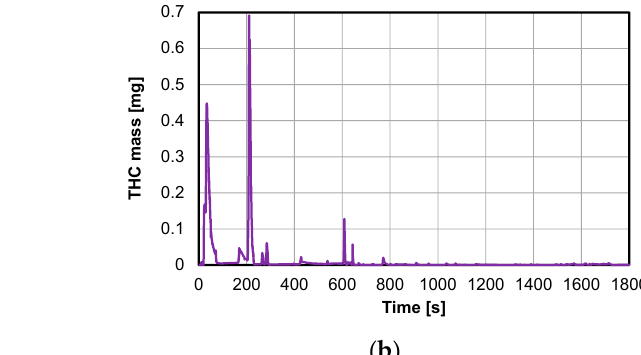
Energies 2022 , 15 , x FOR PEER REVIEW 20 of 40